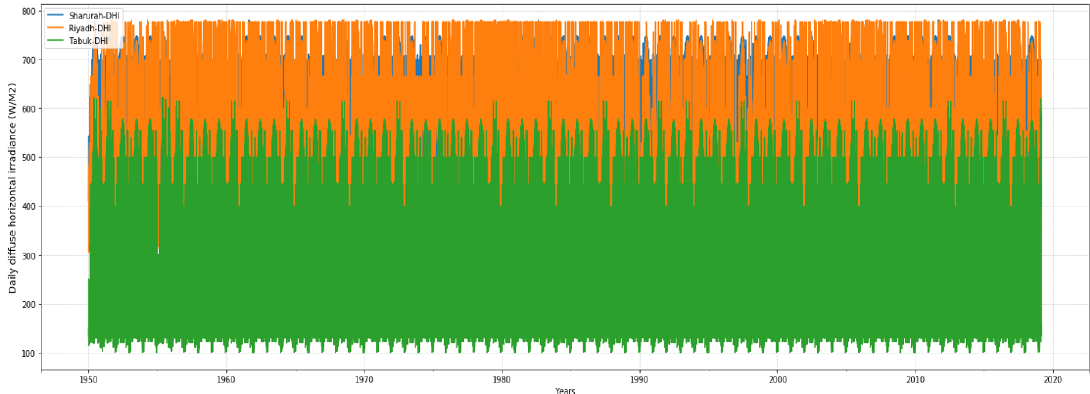
Figure 3. The diffuse horizontal irradiance performance of the three regions.